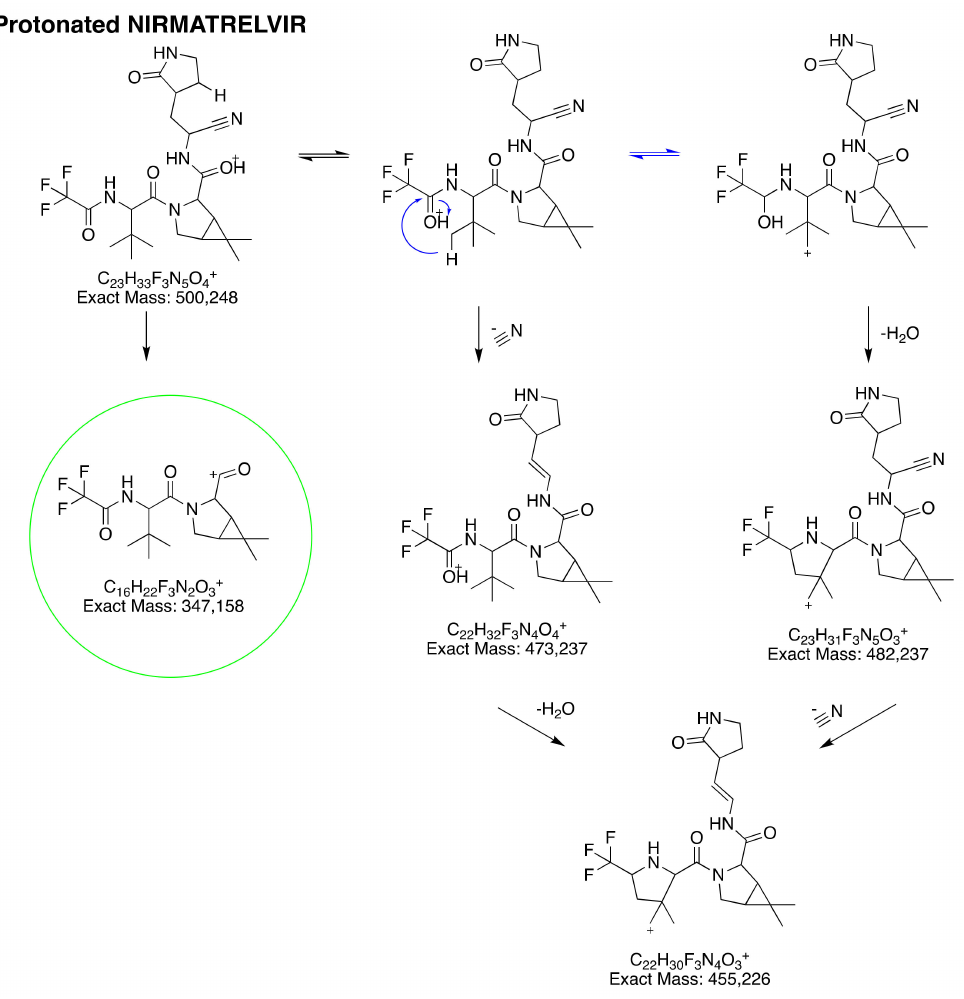
Figure 2. Proposed fragmentation pattern of protonated nirmatrelvir. The structure of the base peak-ion is circled in